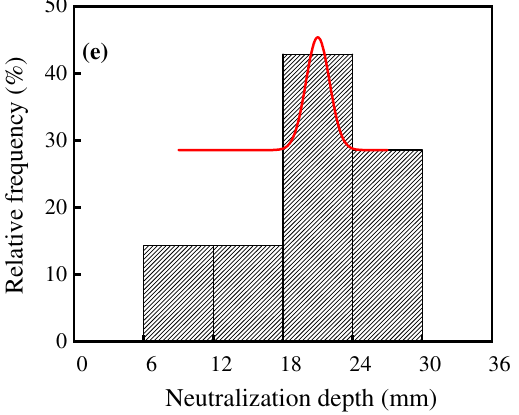
Figure 8. Frequency distribution histograms of concrete neutralization depth in various sections of the ammonium sulfate workshop. ( a ) Warehouse; ( b ) synthesis section (indoor); ( c ) synthesis section (outdoor); ( d ) vulcanization bed section; ( e ) crystallization tank